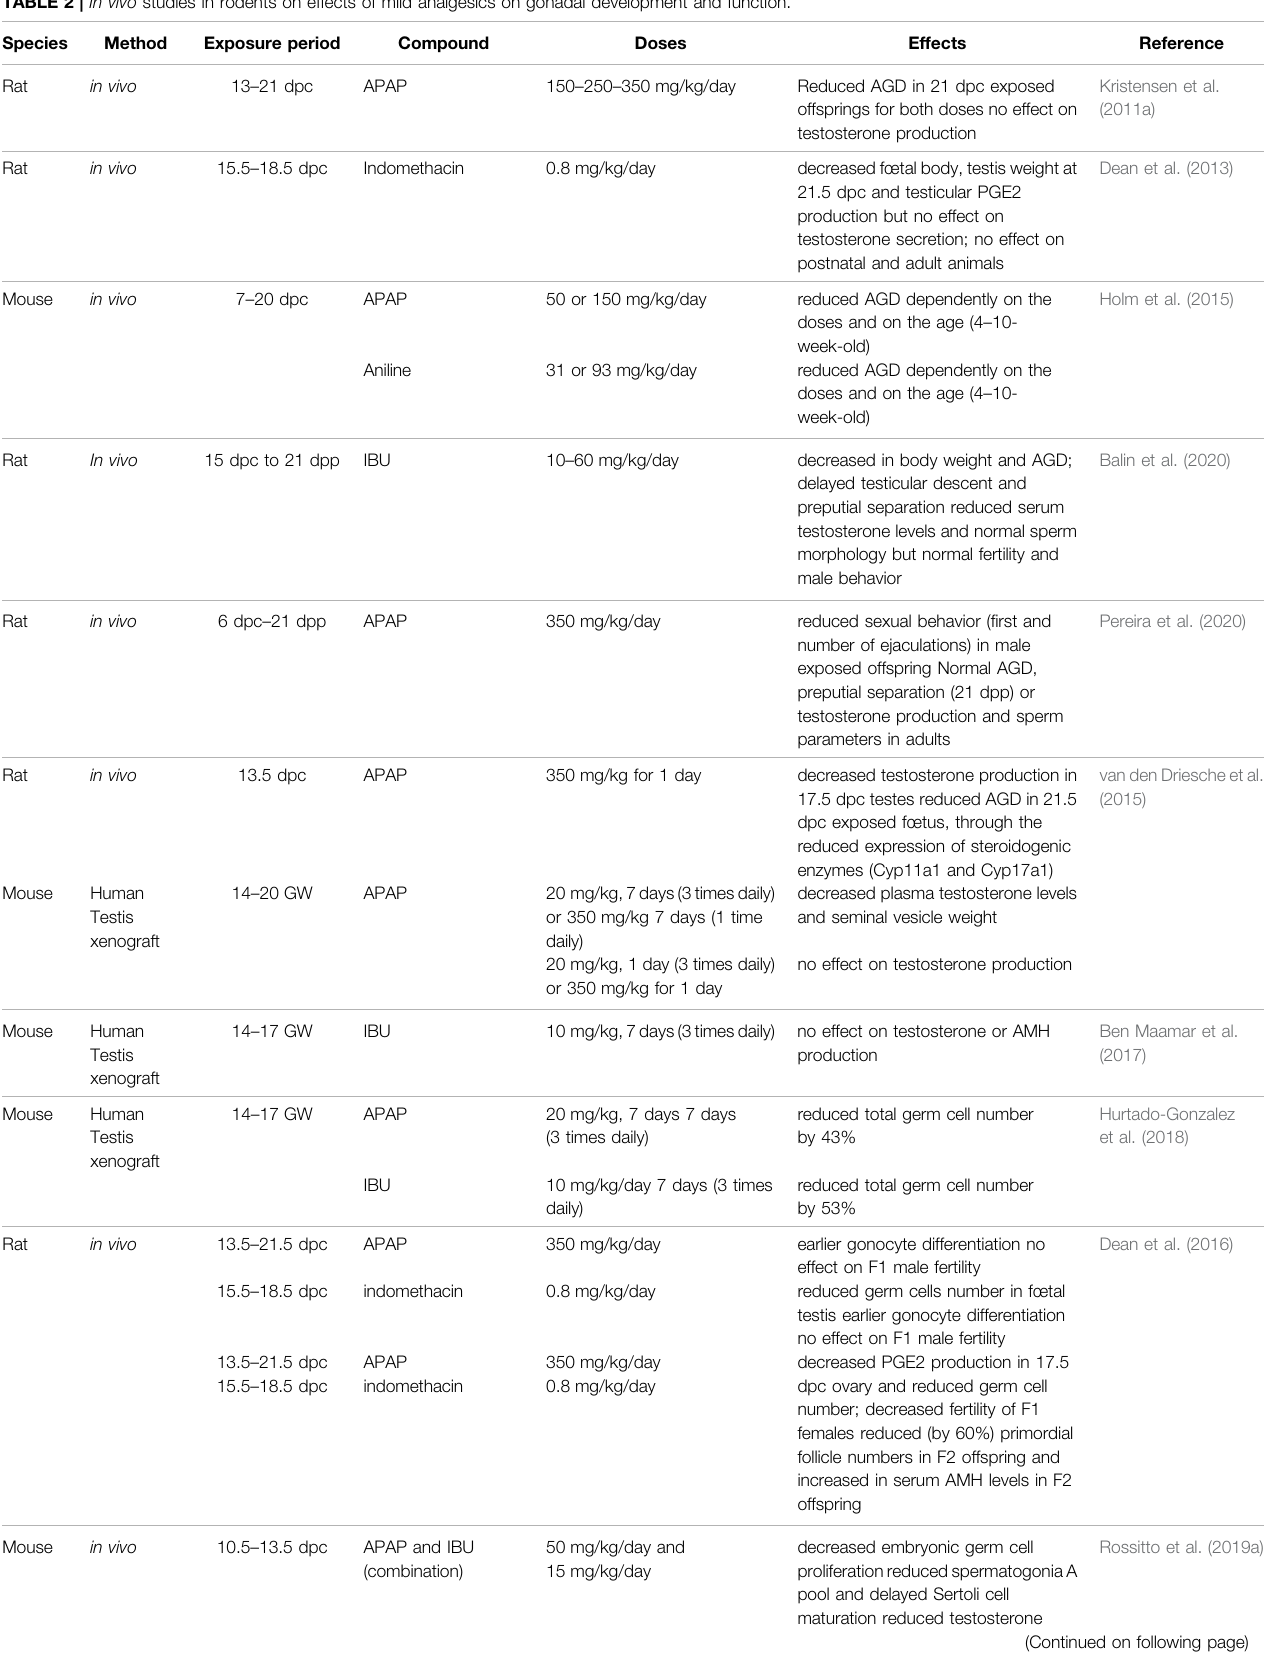
TABLE 2 | In vivo studies in rodents on effects of mild analgesics on gonadal development and